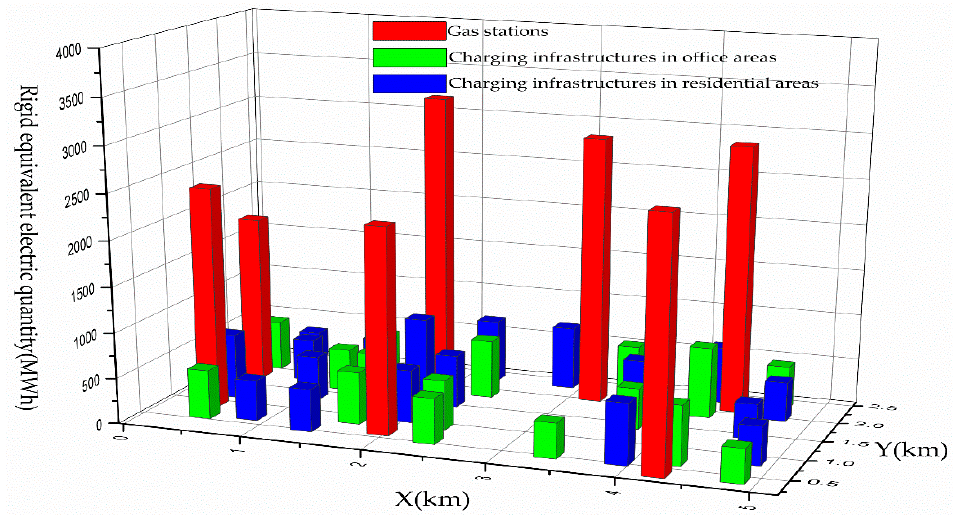
Figure 7. The geographical locations of REEQ.